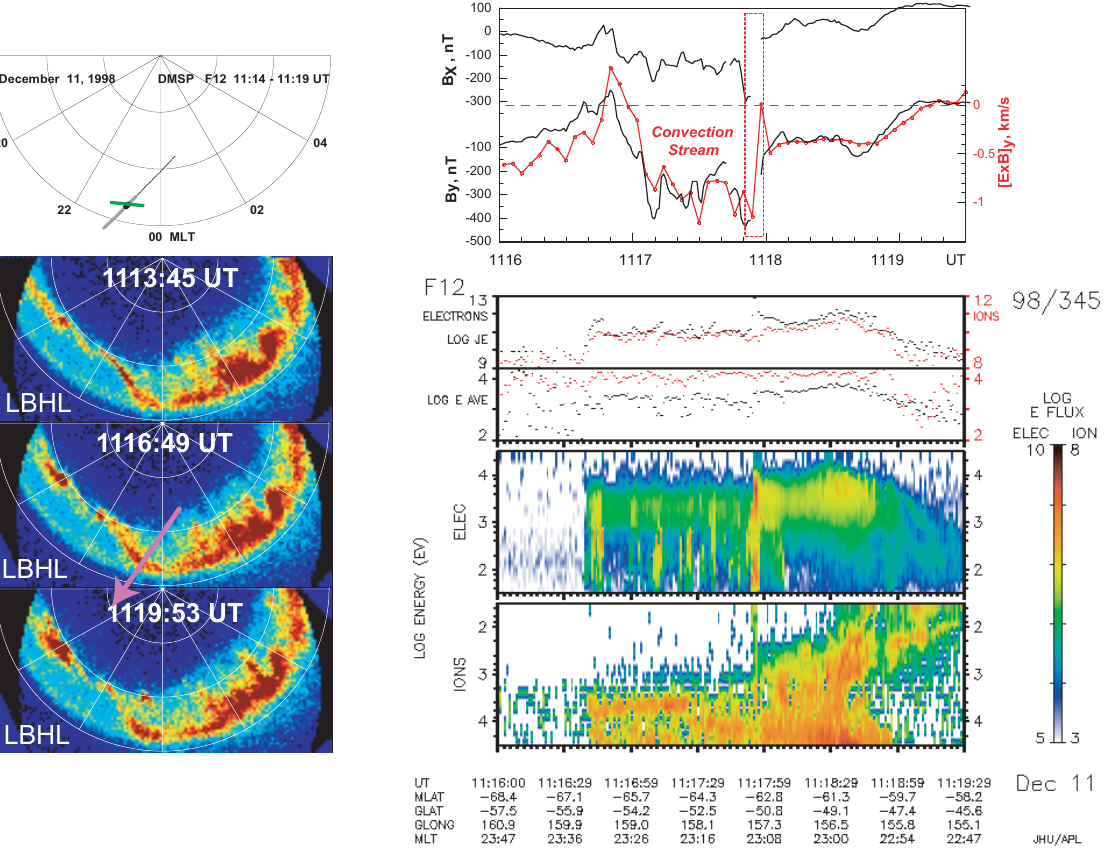
Fig. 2. Summary of DMSP F12 observations during the streamer crossing at 11:18